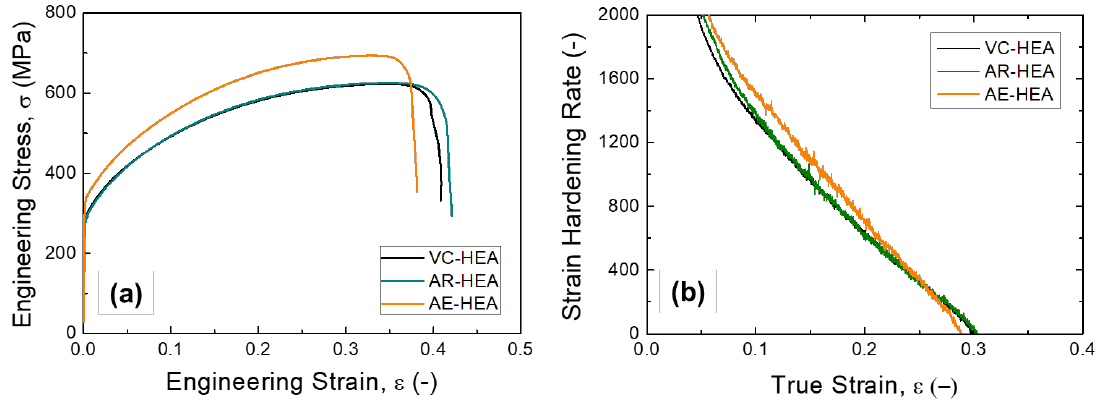
Figure 7. ( a ) Engineering stress–strain curves and ( b ) strain-hardening rate curves of HEAs.